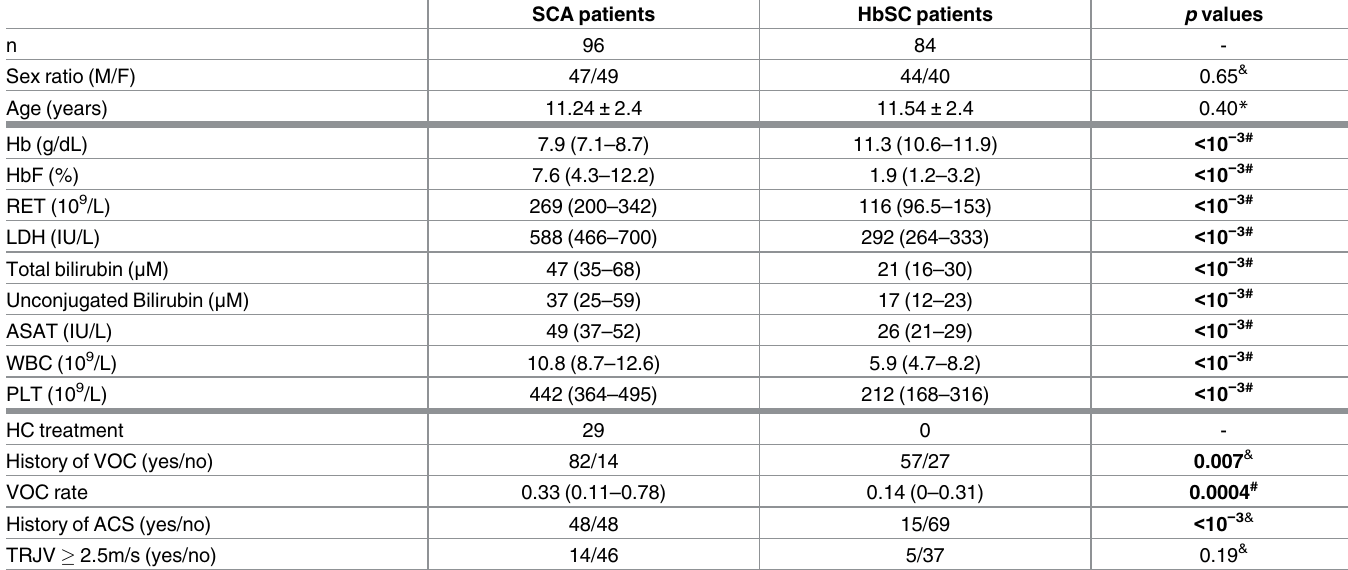
Table 1. Biological and clinical characteristics of the SCD studied patients.